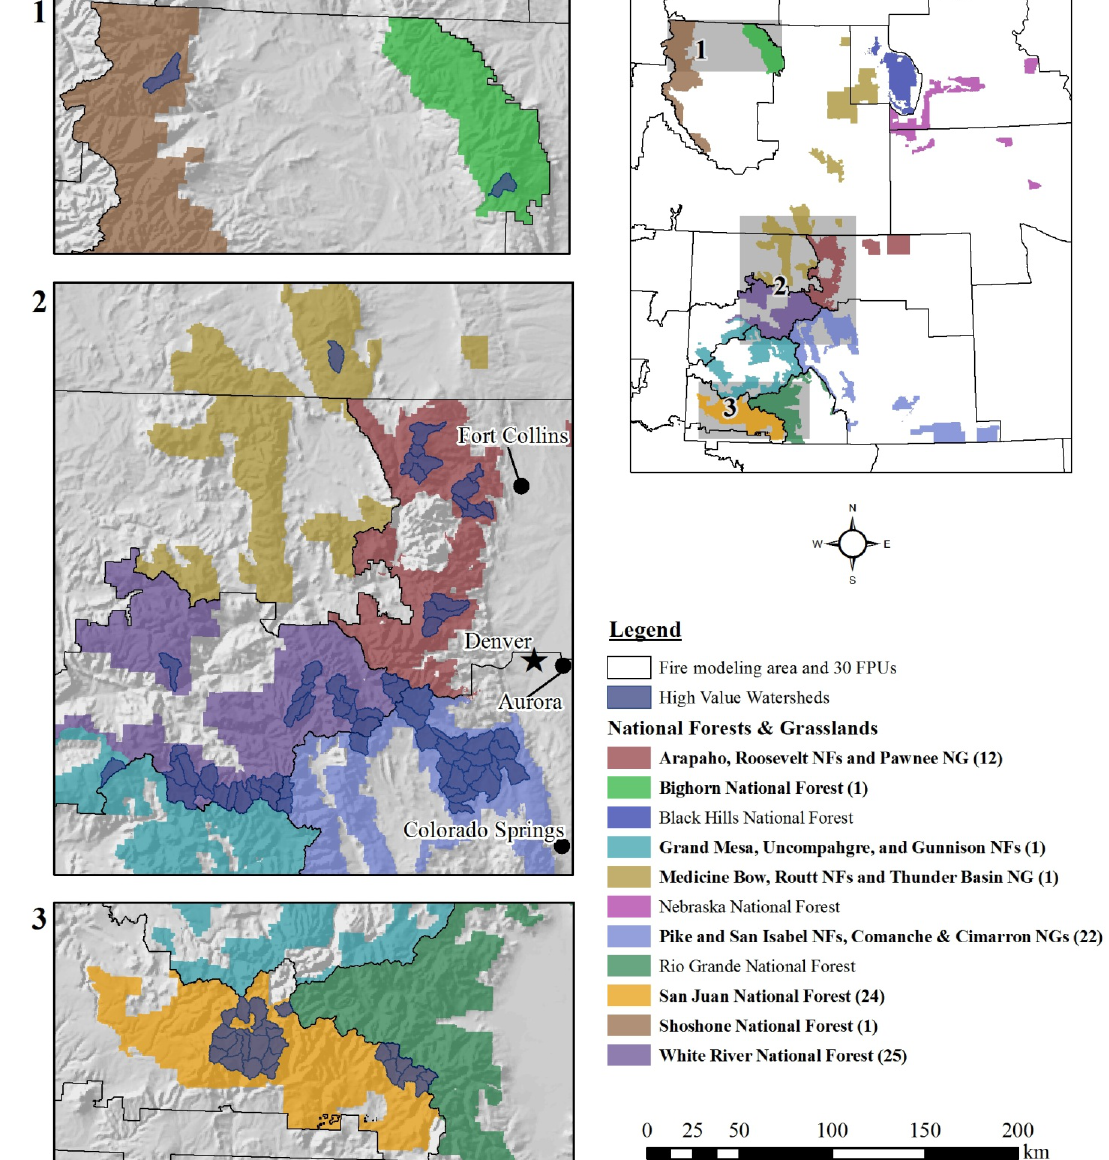
Figure 3. Fire modeling area (upper right box), with National Forest (NF) and Grassland (NG) boundaries and Fire Planning Unit (FPU) boundaries identified. The location and number of high value watersheds within each NF/NG are also identified (left three panels). Note that in the inset map state boundaries are not shown to allow for clearer presentation of FPU